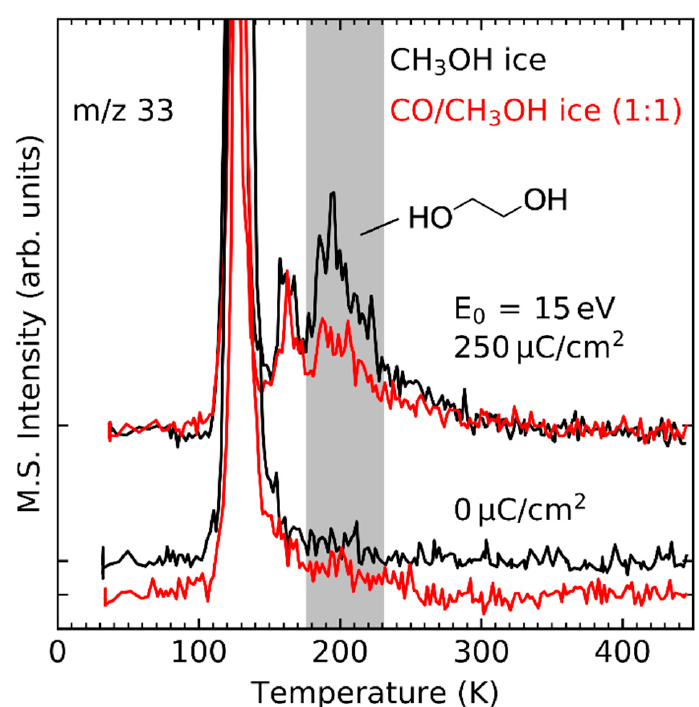
Figure 8. Thermal desorption spectra of pure CH 3 OH (black lines) and CO/CH 3 OH (1:1) mixed ices (red lines) after irradiation with 250 µ C/cm 2 and without electron exposure (denoted as 0 µ C/cm 2 ). The signals at 160 K and 195 K in the m / z 33 curves are assigned to methoxymethanol and ethylene glycol, respectively. The desorption signal at ~130 K is due to the 13 CH 3 OH isotopologue. The TDS data show that signal intensities of the products decrease upon mixing CH 3 OH with CO. Adapted from Ref. [26] with permission from the PCCP Owner Societies.